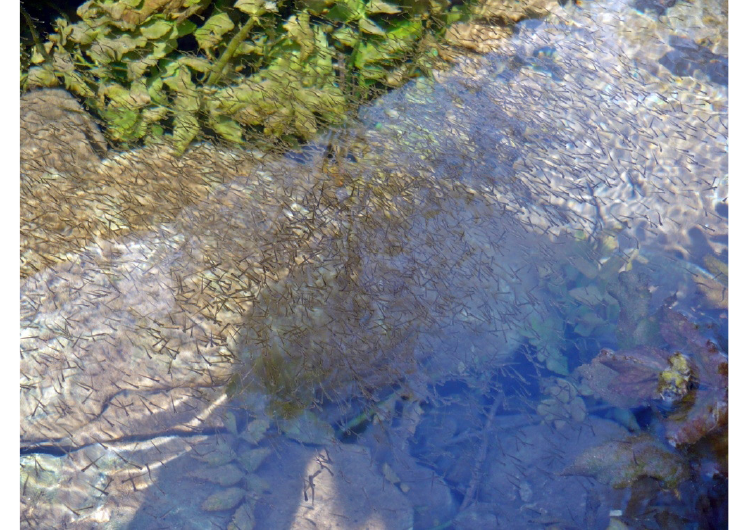
Fig. 4. Larvae school of the Neretva nase, Chondrostoma knerii , grouped on flooded meadows (Photo by